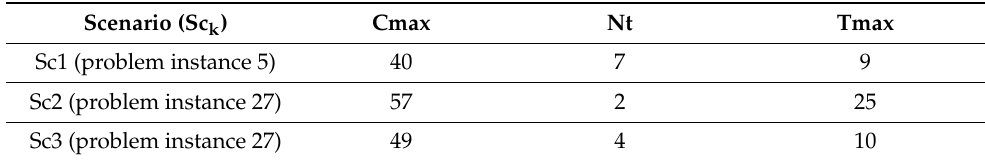
Table 4. Best scheduling problems results.